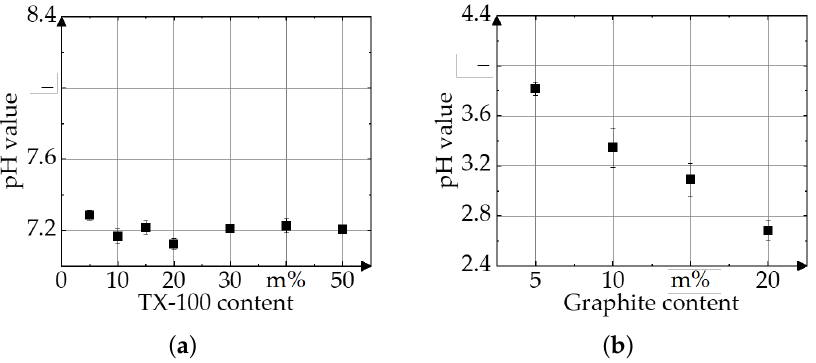
Figure 6. PH value as a function of ( a ) TX-100 content for a solution without nanoparticles (see Table A9) and ( b ) graphite content for aqueous dispersions containing 40 m% TX-100 (see Table